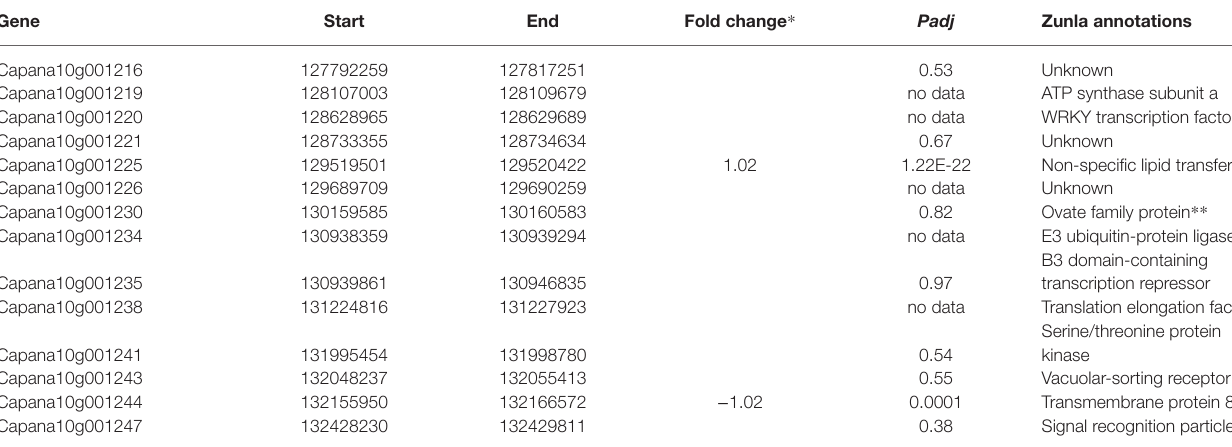
TABLE 4 | Genes contained within the 5-Mbp fs10 region and their expression in RNAseq of the F 2 fruit shape index bulks. Gene Start End Fold change *